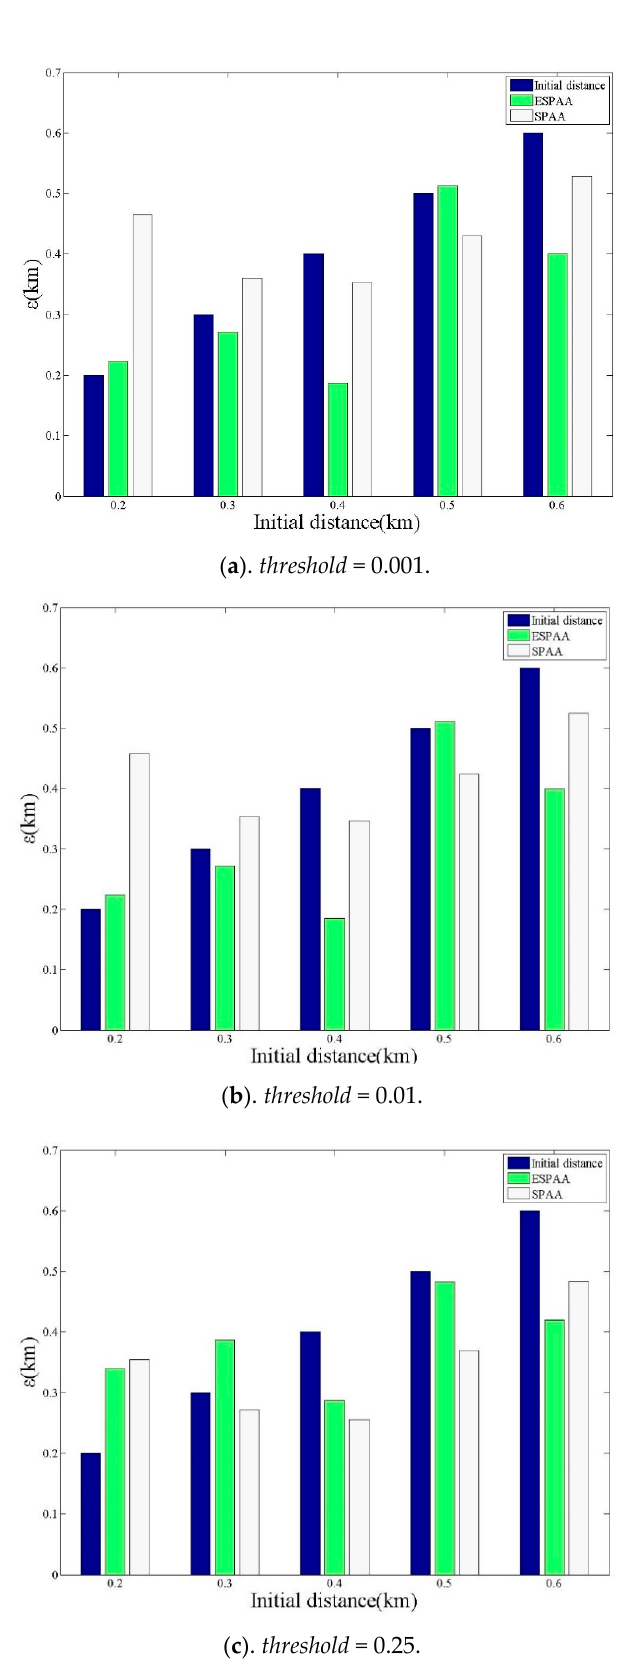
Figure 11. The effect of different threshold on the positioning error value ( a ) threshold = 0.001 ( b ) Figure 11. The e ff ect of di ff erent threshold on the positioning error value ( a ) threshold = 0.001 ( b ) threshold = 0.01 ( c ) threshold = threshold = 0.01 ( c ) threshold = 0.25.